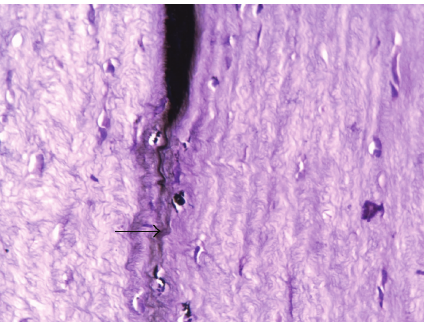
Figure 8: A photomicrograph of rabbit cornea group II, showing minimal diffusion of the black pigment at the adjacent corneal stroma (arrow). H&E × 400.